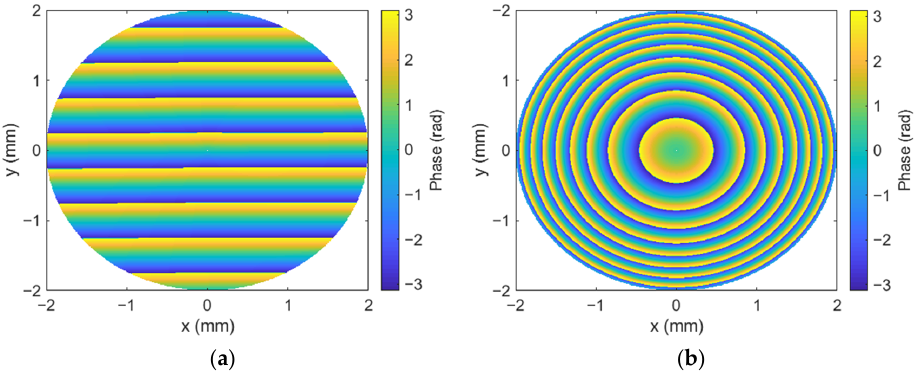
Figure 1. Distribution of the phase argument of the ( a ) object wave and ( b ) reference wave in the hologram recording